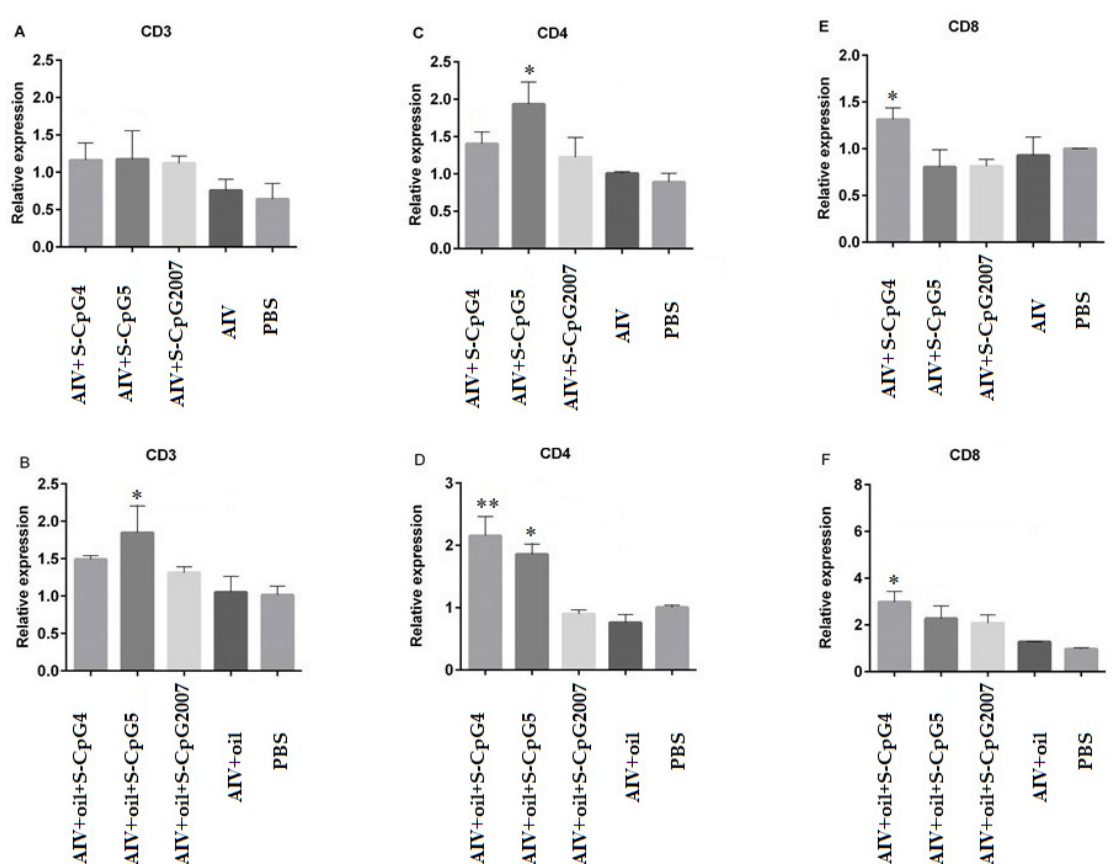
Figure 7. Expression levels of CD3, CD4, and CD8 on splenic lymphocytes. The expressions of CD3 ( A ), CD4 ( C) and CD8 ( E ) of splenic lymphocytes from immunized with S-CpG4, 5 and S-CpG2007 and AIV antigen were detected with qPCR, and expressions of CD3 ( B ), CD4 ( D ) and CD8 ( F ) from immunized with S-CpG4, 5 and S-CpG2007 and AIV antigen with oil adjuvantt were meas- ured with qPCR. All data were presented as mean ± SD. * p < 0.05, ** p < 0.01.